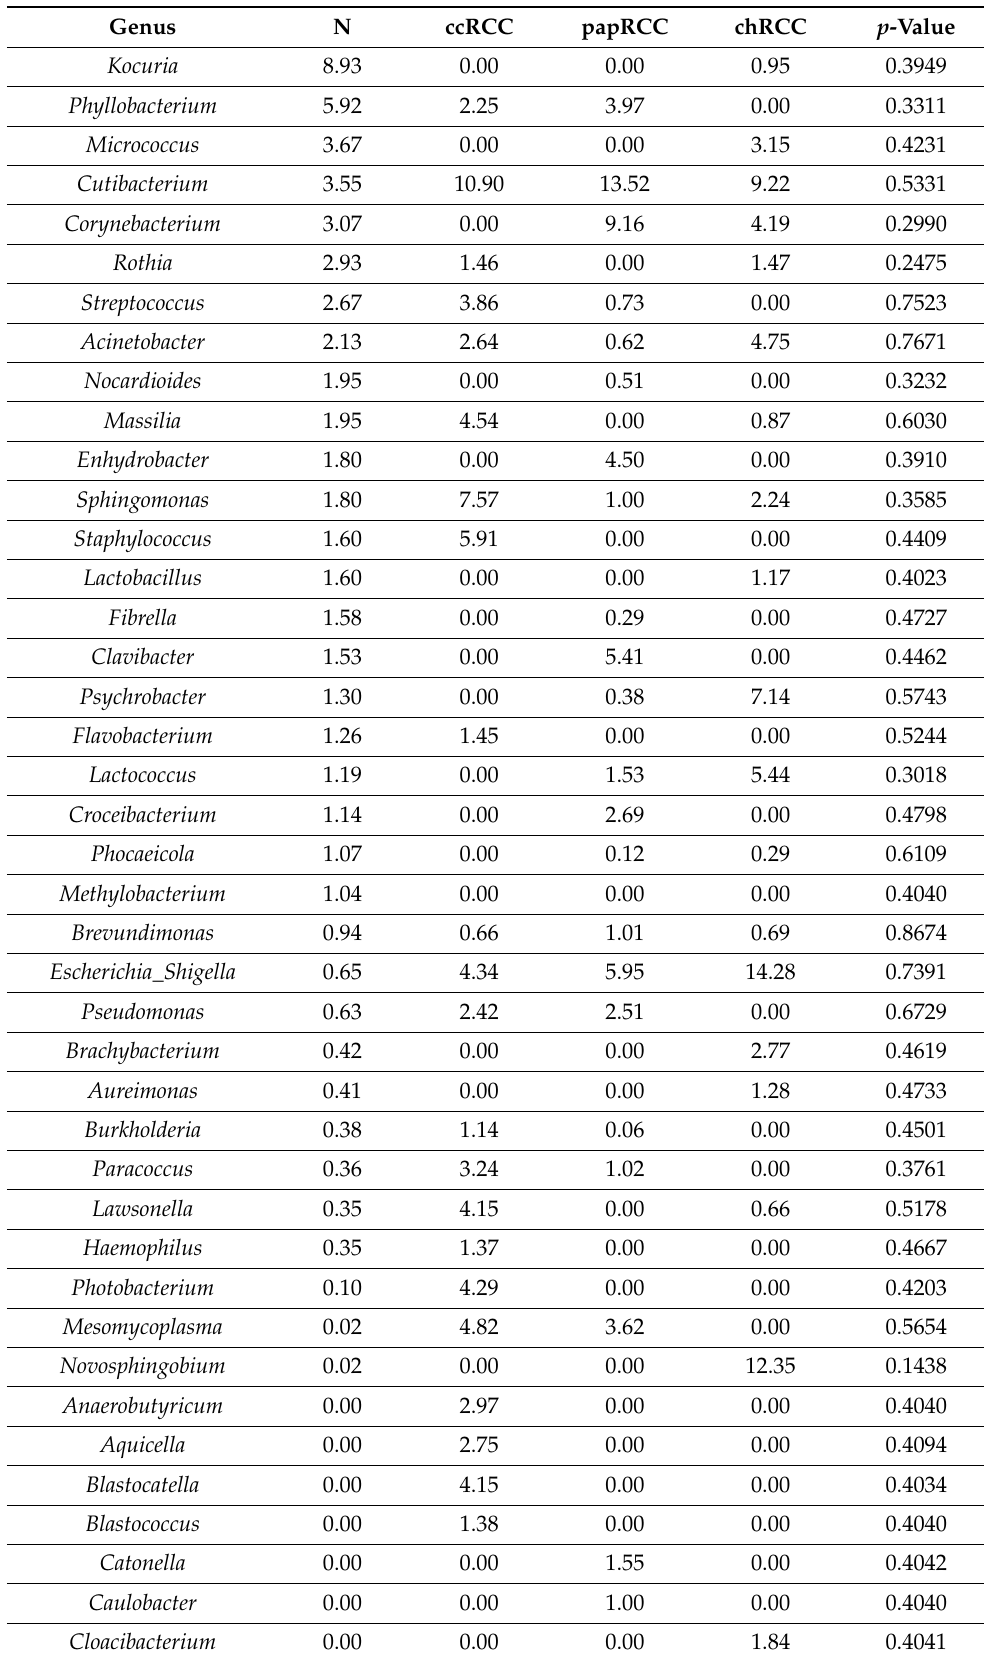
Table 3. Taxonomic composition of kidney tumors at the genus